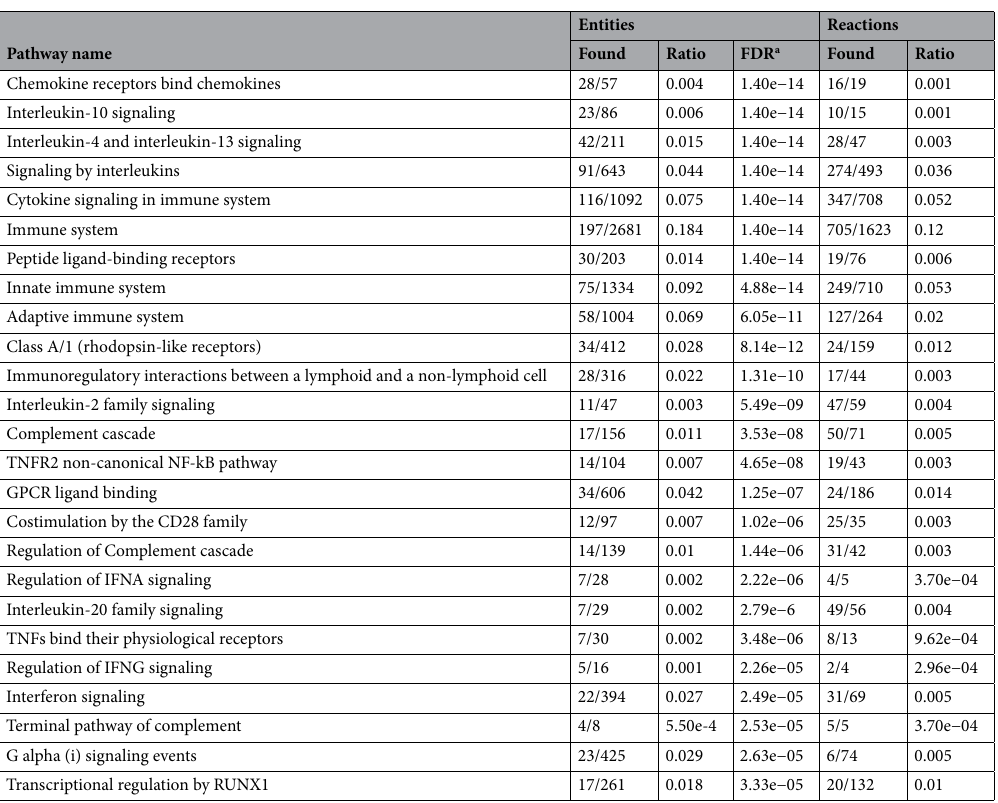
Table 2. Reactome pathways sorted by p-value for the 217 differentially expressed genes after LyoVec poly(I:C) stimulation by cluster. a False discovery rate.